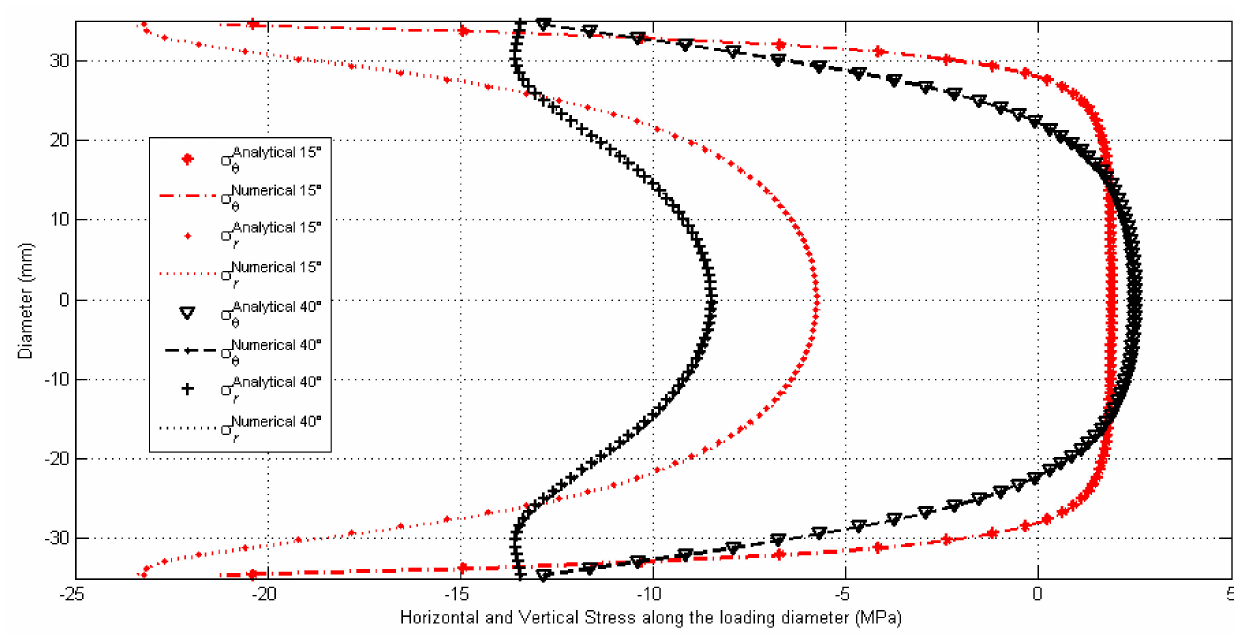
Figure 8. Distribution of horizontal and vertical stress through the loading diameter in the disk tested by [8] in the case of 2 α = 15–40 ◦ (compression − , tension